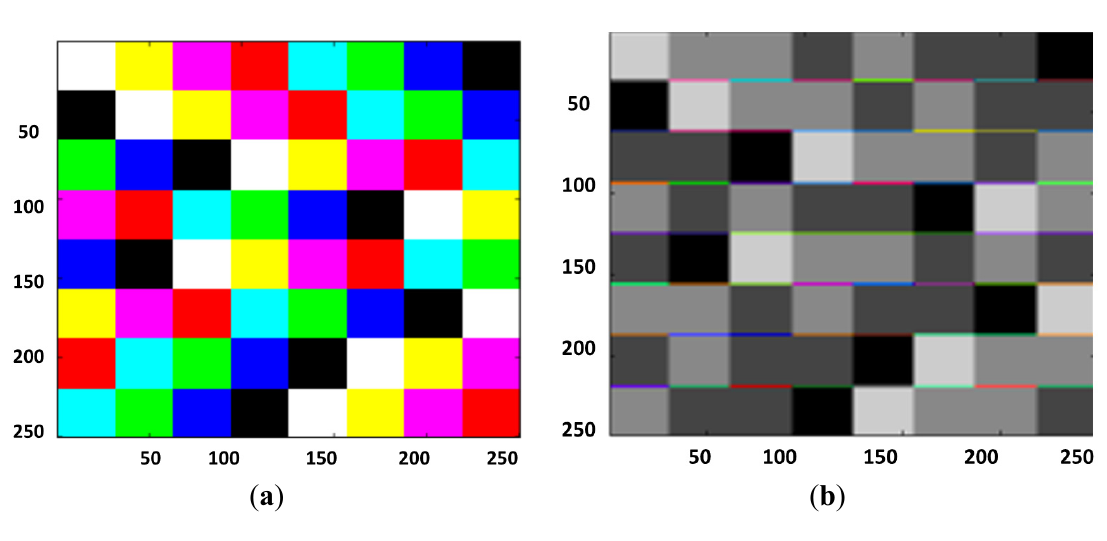
Figure 6. ( a ) Original Color Block and ( b ) Color Block after Rotor Convolution.